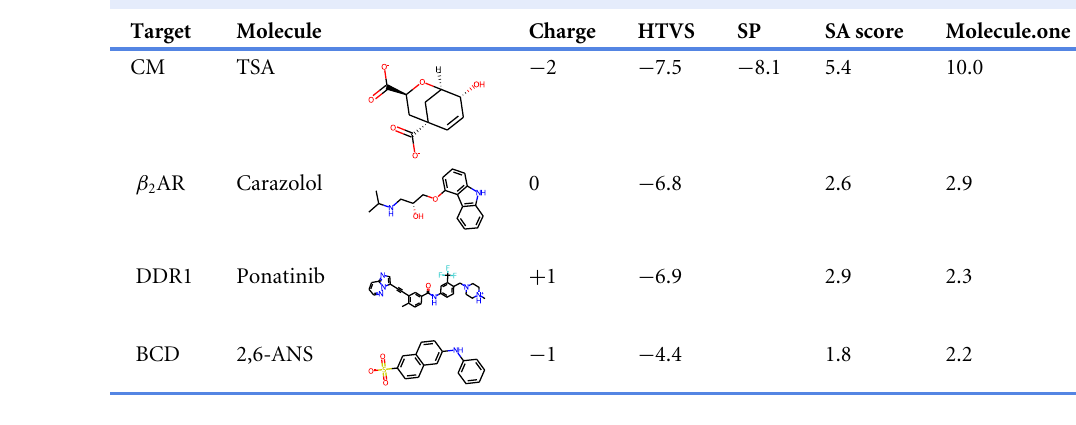
Table 1 Docking scores in kcal/mol, heuristic synthetic accessibility scores, and Molecule.one scores